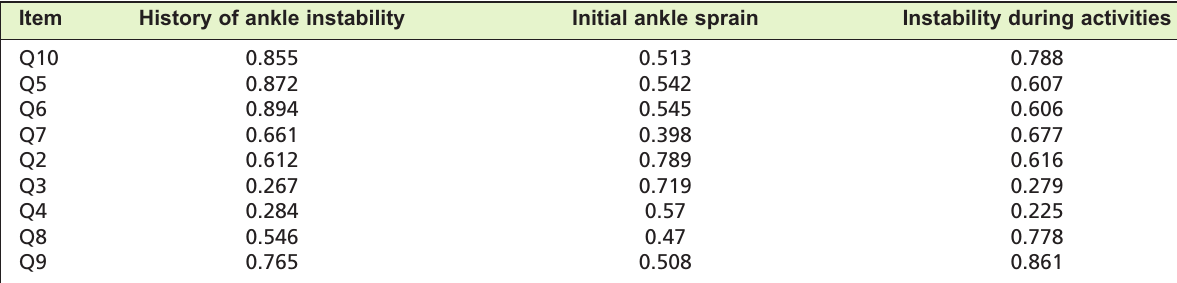
The cross-loading value between each item and the constructs Table V: